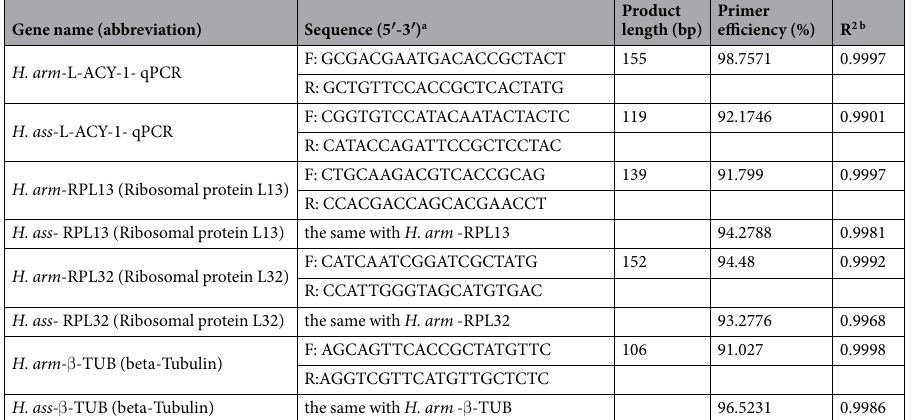
Table 2. Primer pairs used for qRT-PCR analysis of the target or reference genes. a F and R respectively indicate forward primer and reverse primer. b R 2 refers to the coefficient of determination.